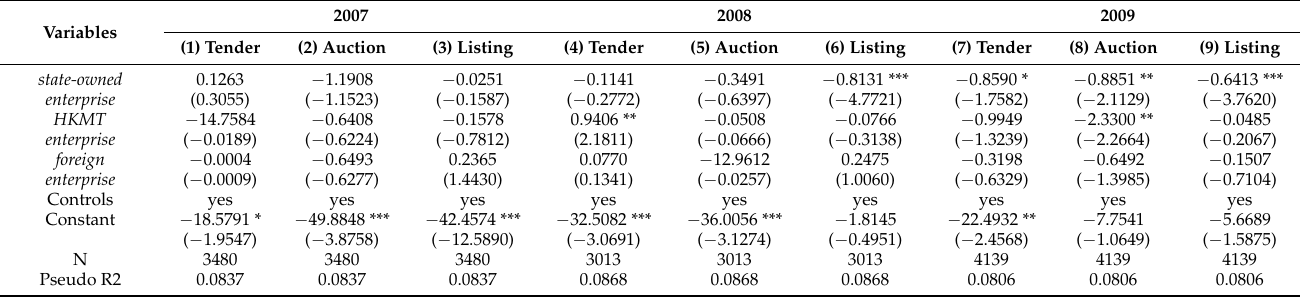
Table A1. Results of mlogit model considering types of enterprises